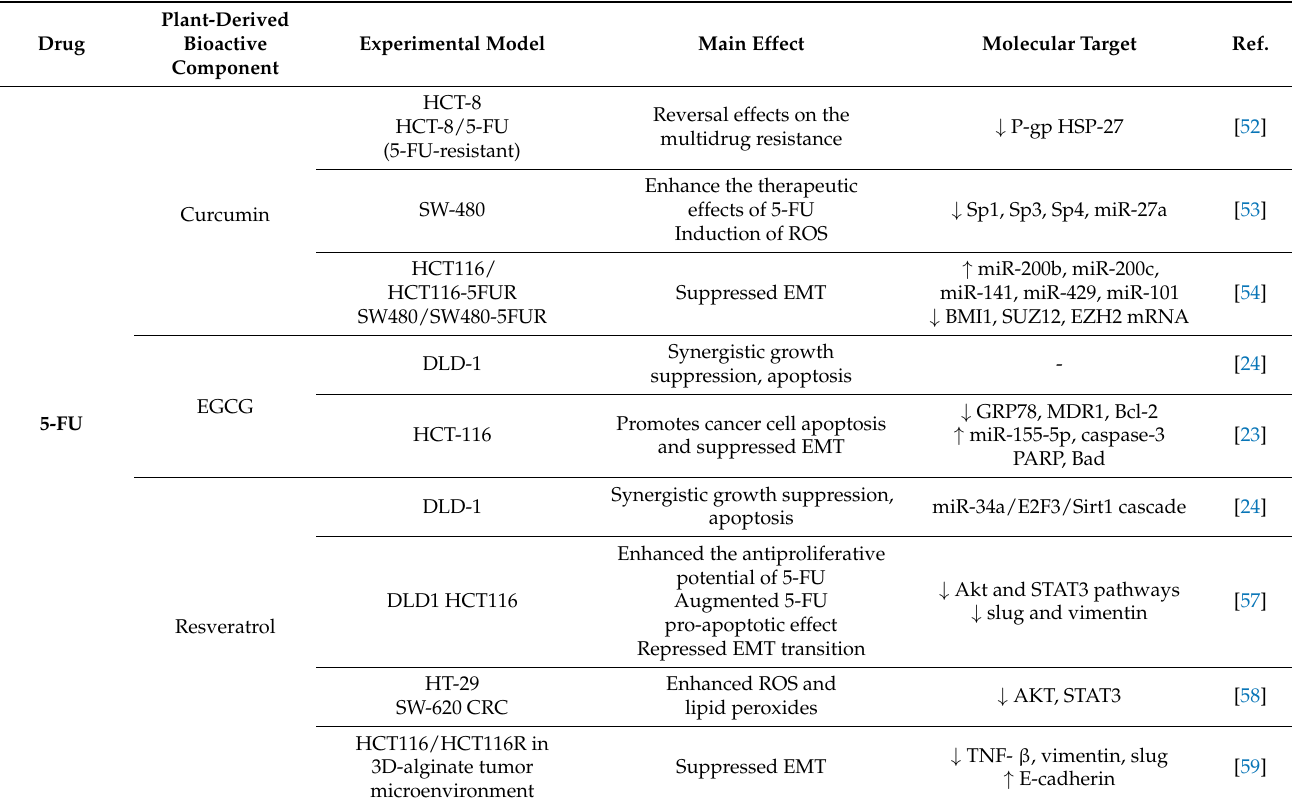
Table 1. Main in vitro and in vivo effects of chemotherapeutic agents in combination with plant- derived bioactive components against